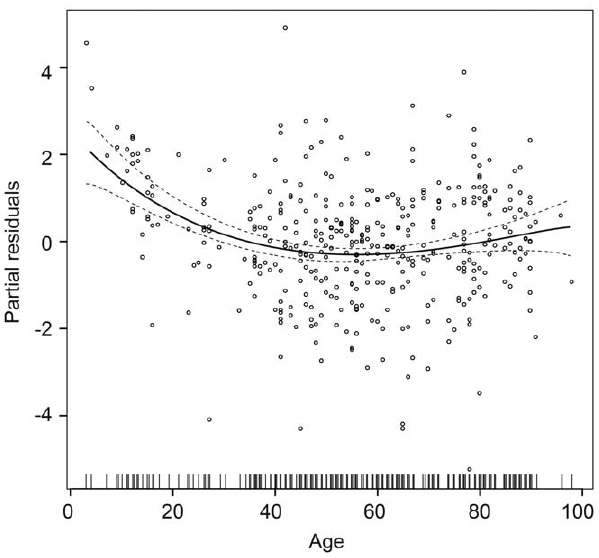
Figure 1. Partial residual plot showing the effect of age on total nightly sleep duration of all subjects (n=469). No differences in sleep duration were found between the three different subject groups. Dashed lines indicate 95% confidence intervals.